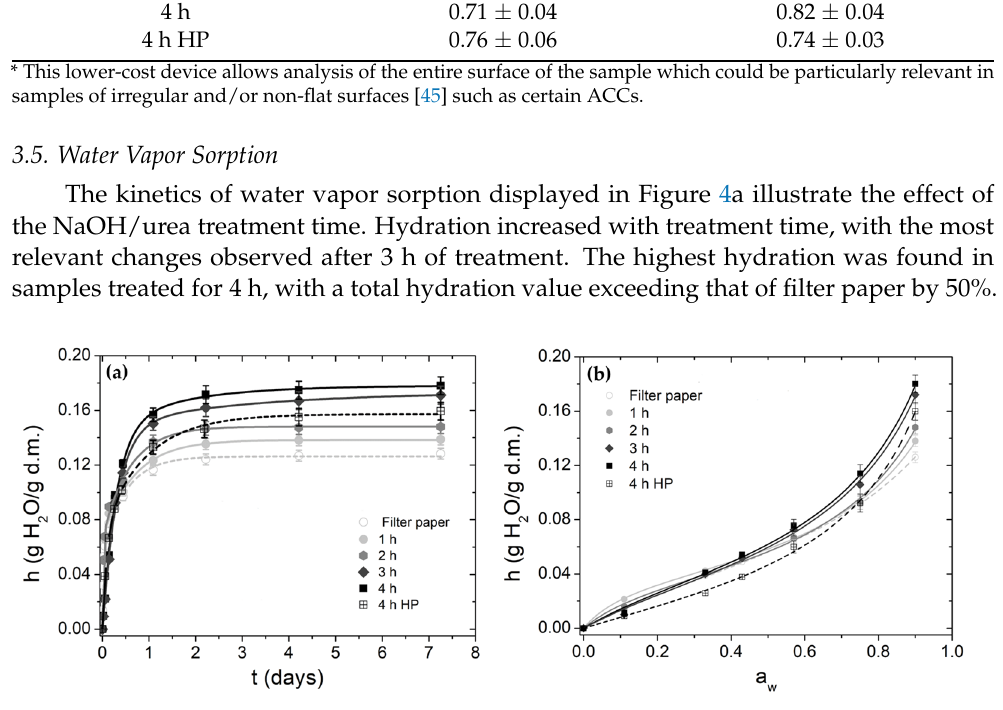
Figure 4. ( a ) Kinetics of water sorption at 90% r.h. ( b ) Water sorption isotherms. Kinetics were fitted with biexponential model (Equation (6)) and sorption isotherms were fitted with the GAB (Equation (7)) model.